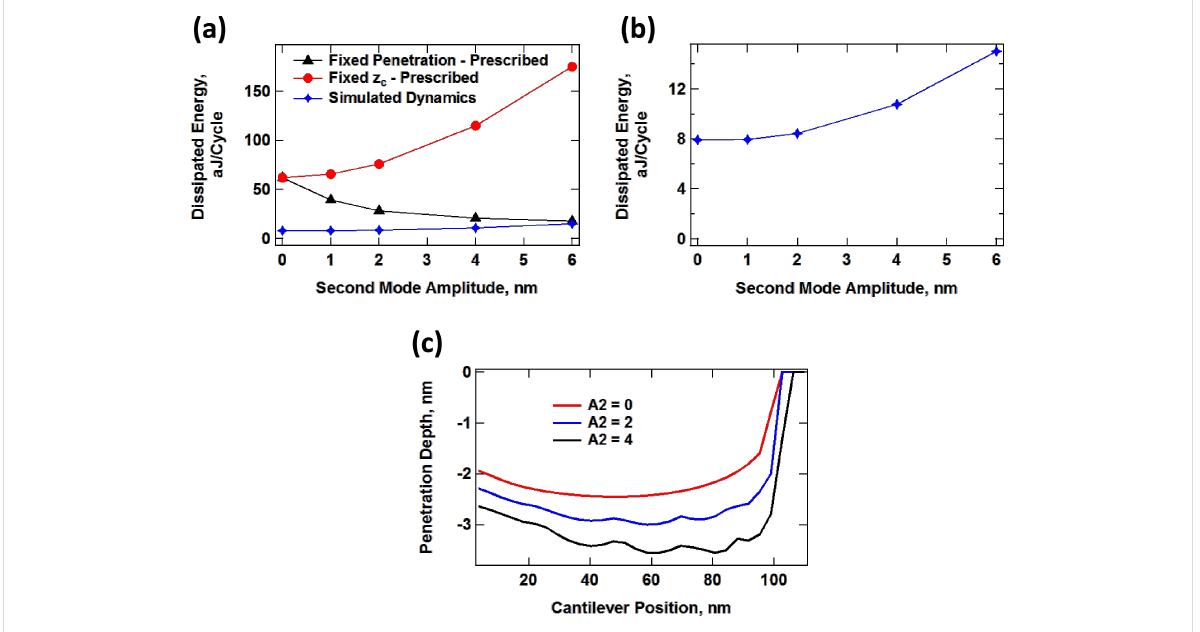
Figure 8: (a) Dissipated energy vs second eigenmode free amplitude for an SLS surface interacting with a tip following a prescribed bimodal oscilla- tion with constant penetration maximum (see Figure 5), a prescribed bimodal oscillation with variable penetration maximum (see Figure 6) and a real- istic dynamics trajectory solved in real time for AM-OL operation (see Figure 7); (b) expanded view of the result for the realistic dynamics trajectory (same trace as in (a) but plotted by using a different scale); (c) lowest tip position reached by the tip over 15 fundamental cycles after reaching steady state as a function of cantilever rest position during a simulated spectroscopy measurement for the realistic tip trajectory using the parameters given for Figure